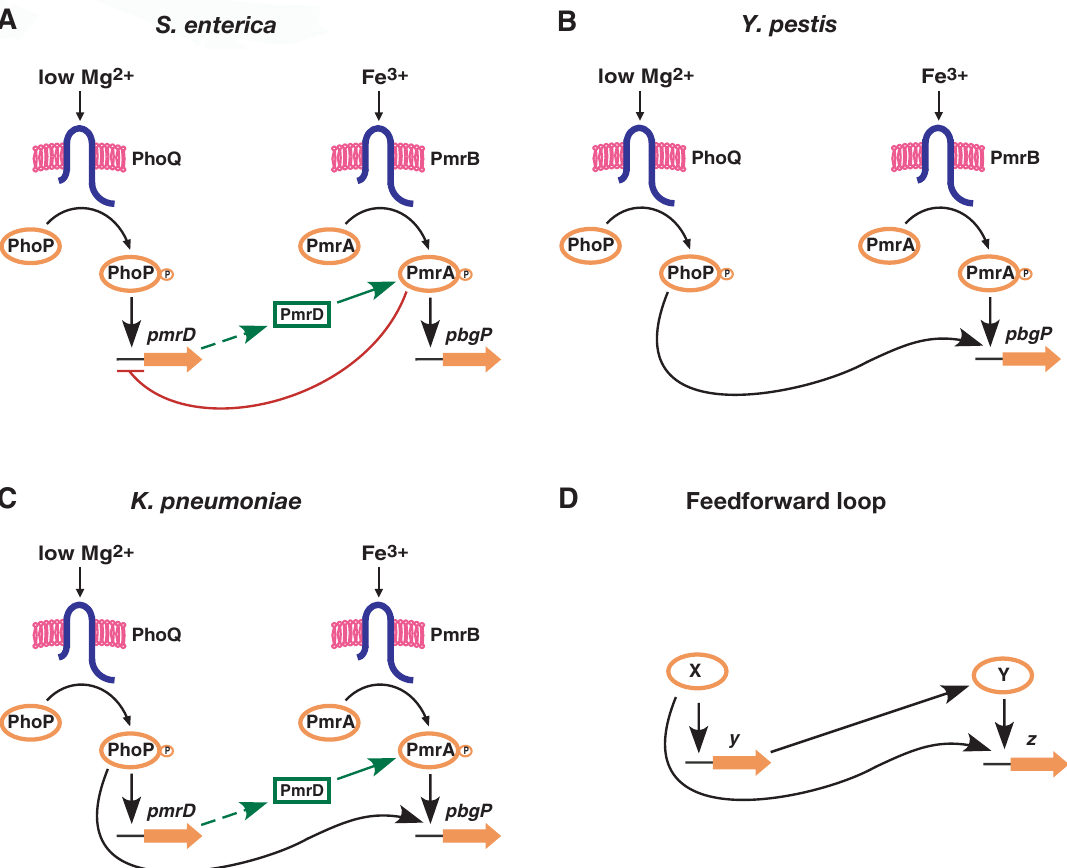
Figure 1. Regulatory architectures controlling expression of the polymyxin B resistance operon pbgP in different bacterial species. Also shown is a schematic of the feedforward loop architecture. (A) The connector-mediated pathway activating the pbgP operon in S. enterica . Transcription of pbgP is promoted during growth in low Mg 2 + via the PhoP/PhoQ system, PmrD protein and the PmrA/PmrB system; in the presence of Fe 3 + , it is promoted via the PmrA/PmrB system independently of PhoP/PhoQ and PmrD. The PmrA protein represses transcription of the pmrD gene. (B) The direct activation pathway promoting pbgP transcription in Y. pestis . Transcription of the pbgP gene is promoted during growth in low Mg 2 + directly via the PhoP/PhoQ system, and in the presence of Fe 3 + directly via the PmrA/PmrB system. The pmrD gene is absent from the Y. pestis genome (Figure 2). (C) The feedforward connector loop activating pbgP in K. pneumoniae . Transcription of the pbgP gene is promoted during growth in low Mg 2 + via the PhoP/PhoQ system, the PmrD protein and the PmrA/PmrB system, as well as directly by the PhoP protein binding to the pbgP promoter. In the presence of Fe 3 + , transcription is activated directly by the PmrA/PmrB system, independently of PmrD and PhoP/PhoQ. (D) The feedforward loop. A transcriptional regulator X controls gene z both directly and indirectly, via an additional transcriptional regulator Y that activates gene z .